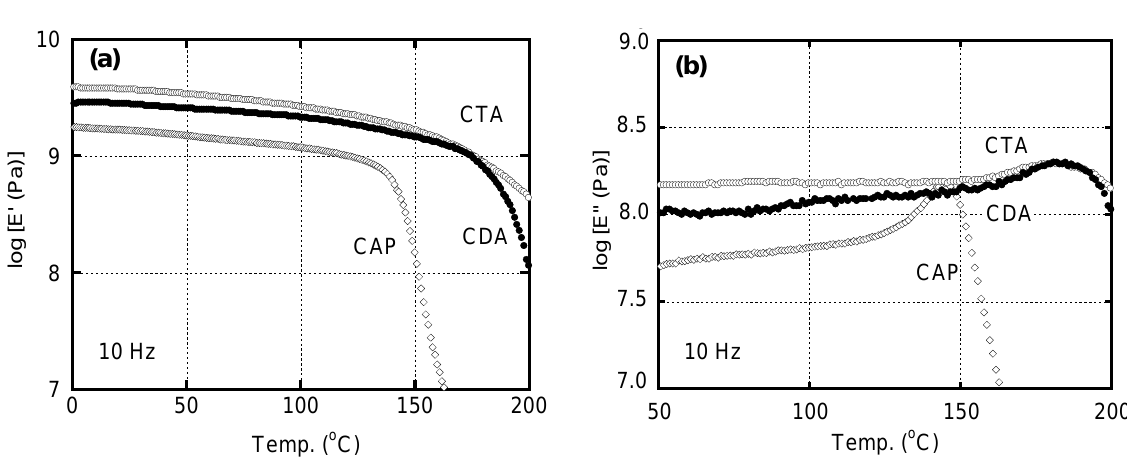
Figure 1. Temperature dependence of (a) tensile storage modulus ' E and (b) loss modulus '' E for cellulose triacetate (CTA), unfilled circles; cellulose diacetate (CDA), filled circles; and cellulose acetate propionate (CAP), unfilled diamonds, at 10